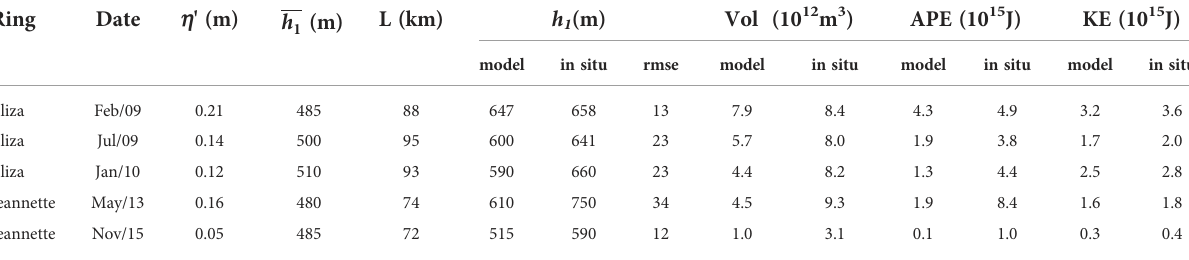
TABLE 1 Parameters used in the two-layer model with reduced gravity. The values of h 1 were obtained from the WOA18 climatology, while h ' and L came from the altimetric map. The depth h 1 at the center of the ring, Volume, Available Potential Energy, and Kinetic Energy were calculated from the model and from the in situ data for rings Eliza and